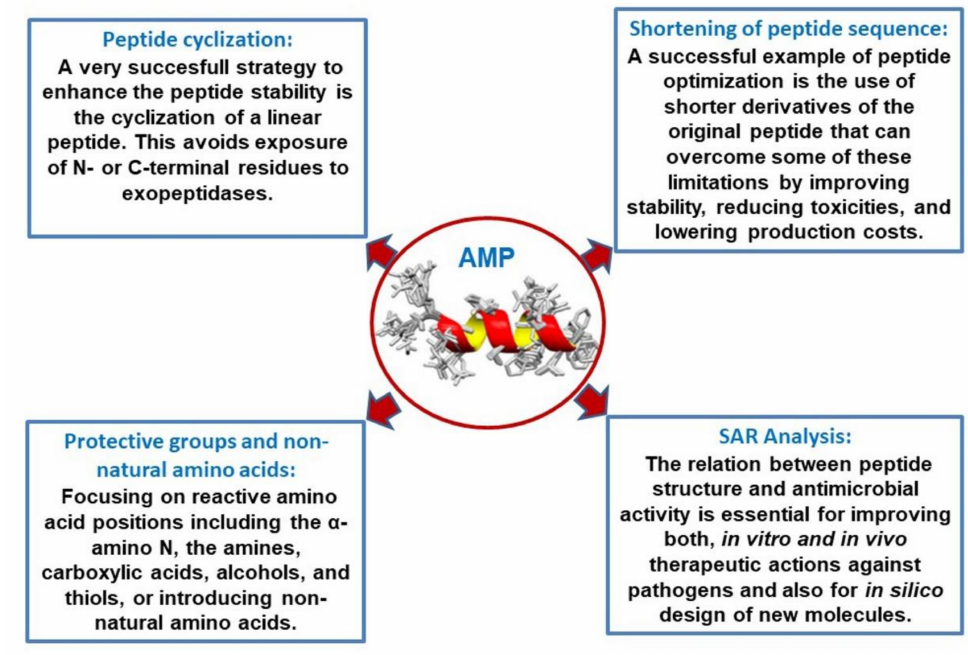
Figure 2. Different key strategies to optimize the structure–activity relationship of an